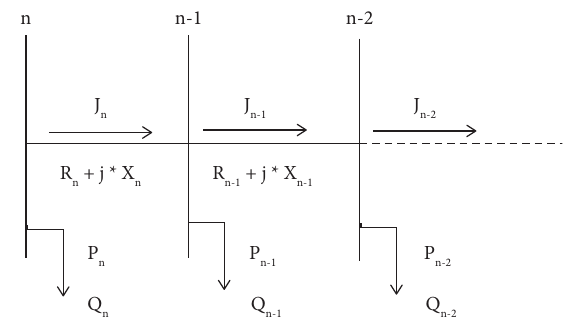
Figure 1: Te load fow analysis in RDS.